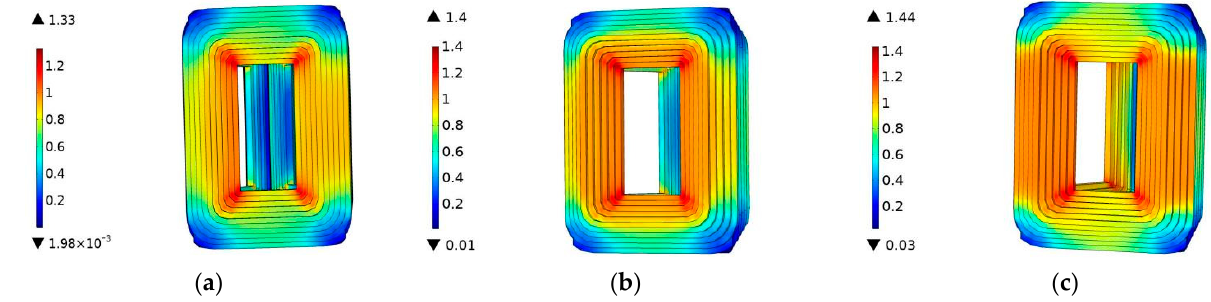
Figure 10. Magnetic density distribution under different voltage excitation ( a ) 0.9 times voltage